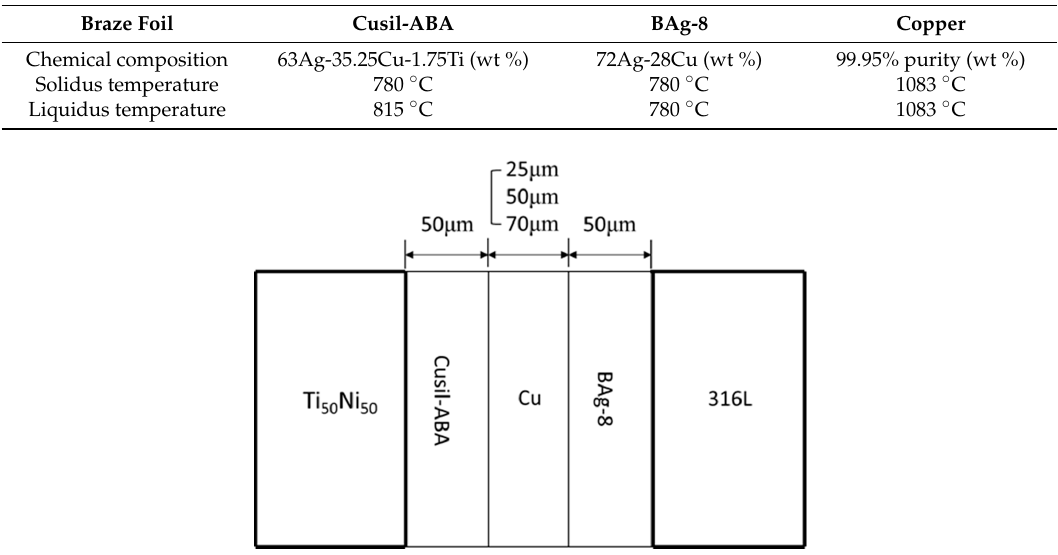
Figure 1. The schematic diagram shows the infrared brazed Ti 50 Ni 50 SMA/Cusil-ABA/Cu foil/BAg-8/316L SS joint. Thicknesses of the copper foils are 25, 50, 70 μ m and those of Cusil-ABA and BAg-8 filler metals are 50 μ m; SMA: shape memory alloy; ABA: active braze alloy.